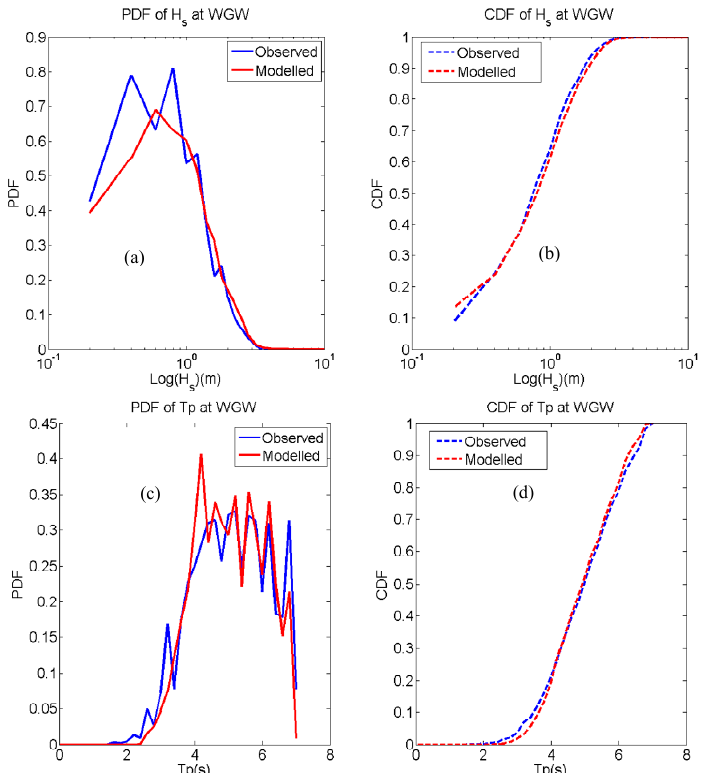
Figure 4. The comparison of H s Probability Distribution Function (PDF) ( a ) and Cumulative Distribution Function (CDF) ( b ) between modelled (red lines) and measured waves at ‘West Gabbard’ WaveNet site (WGW) (blue lines) and the comparisons of T p PDF ( c ) and CDF ( d ) between modelled (red lines) and measured waves at WGW (blue lines). In order to show bigger values of H s , the x-coordinate of H s is scaled by logarithm.